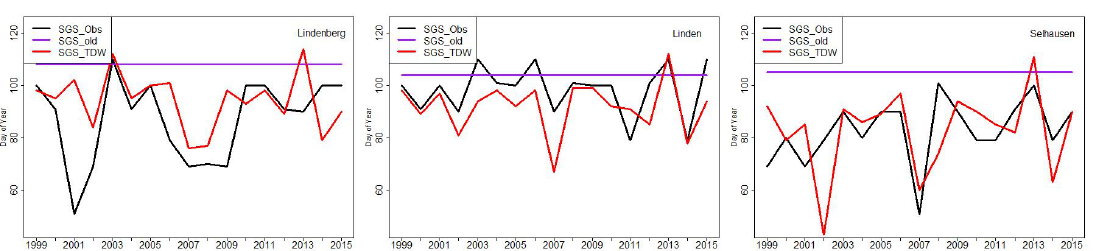
Figure 4. Start of the growing season (SGS) in number of days for each year from 1999 to 2015 and each domain (Lindenberg, Linden, and Selhausen) for satellite observations (_Obs, –), the standard phenology simulations (_old, –), and the new phenology simulations (_TDW,